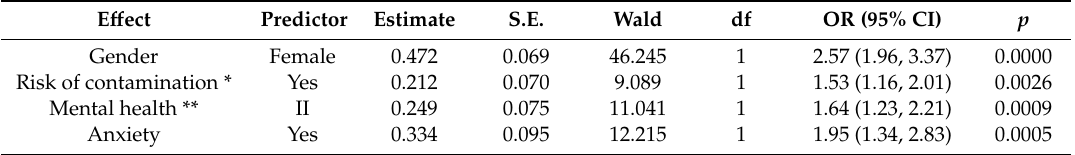
Table 9. Prediction of awake bruxism (AB) in Poland.